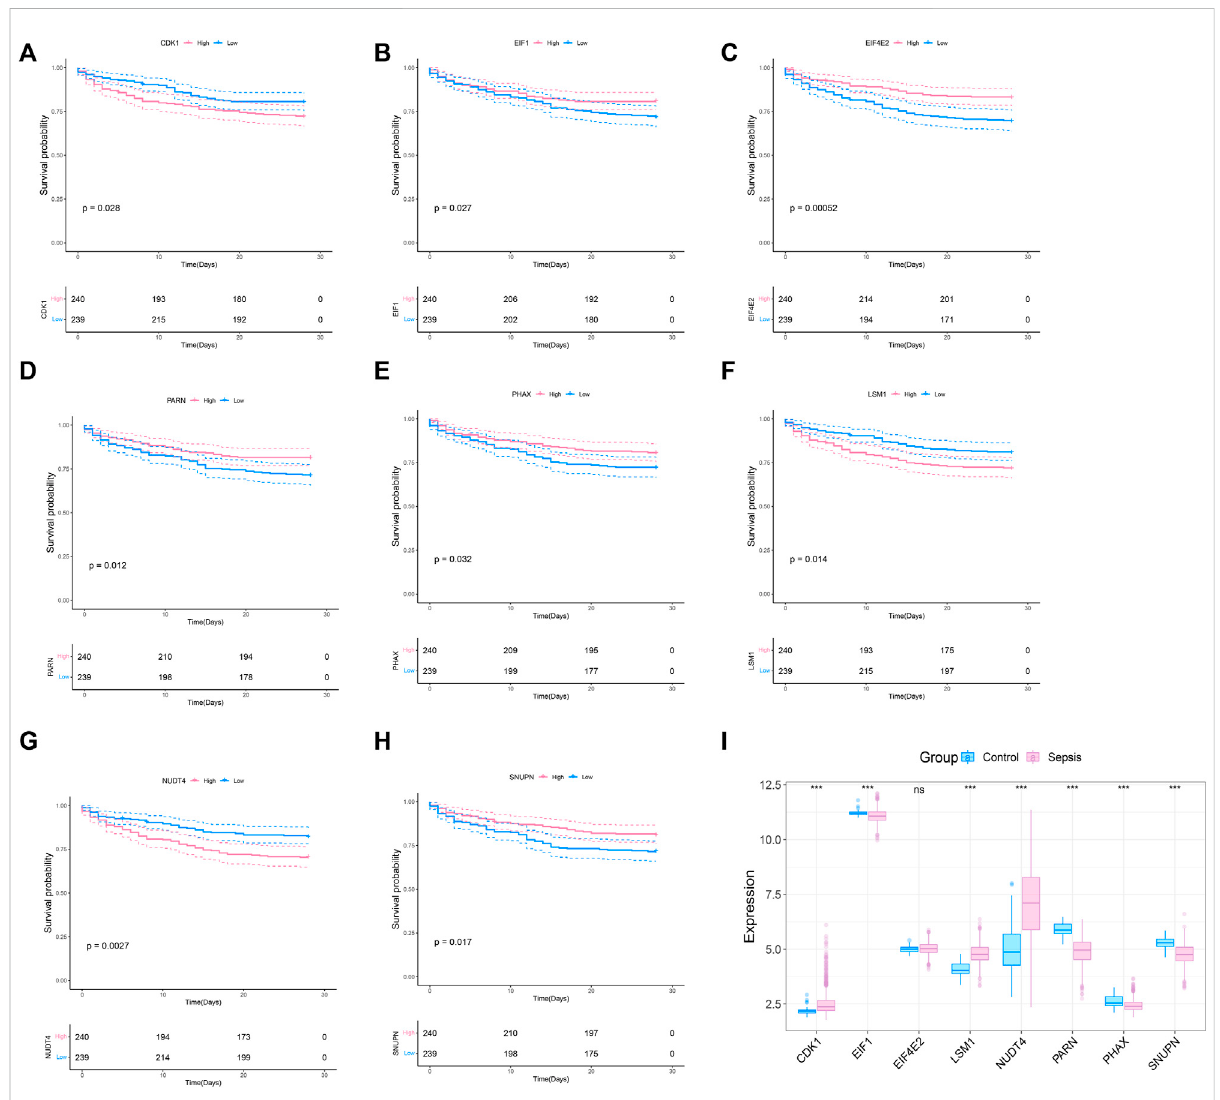
FIGURE 1 Screening ofm7G-related prognosisgenes. (A – H) Survivalanalysis ofm7G generelated tosepsis prognosis.Thepink indicateshigh expression andblueindicateslowexpression. (I) Expressionpro fi leof8prognosticgenesinsepsis,andthemajorityofgenesaredysregulatedinsepsis.Theblue indicates control samples and pink indicates sepsis